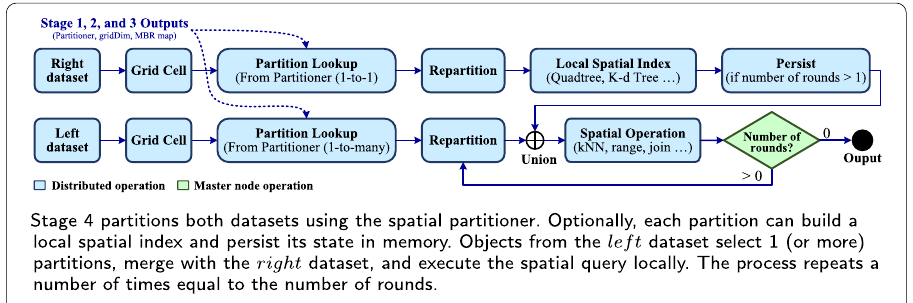
Fig. 8 Stage 4—executing the spatial